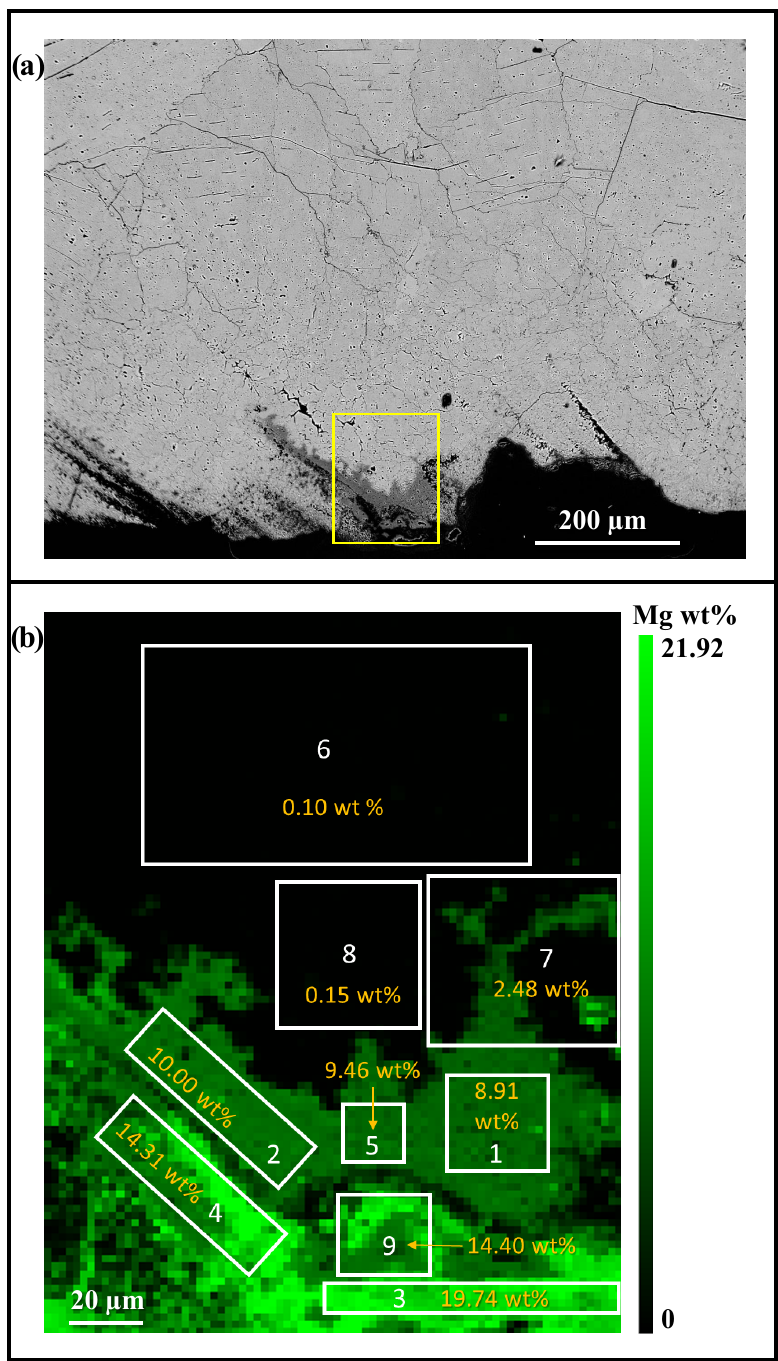
Figure A13. BSE image (a) and Mg concentrations (b) of hydrothermally altered Arctica islandica shell. Alteration occurred in burial solution at 175 ◦ C for 84 days. The yellow rectangle in (a) indicates the shell portion that is shown in (b) and that was scanned with EPMA. White rectangles in (b) highlight the extent of shell portions that were used for the determination of mean Mg concentrations given in yellow within each rectangle. Note the formation of magnesium-rich carbonates (see Table A1) along the outer rim of the